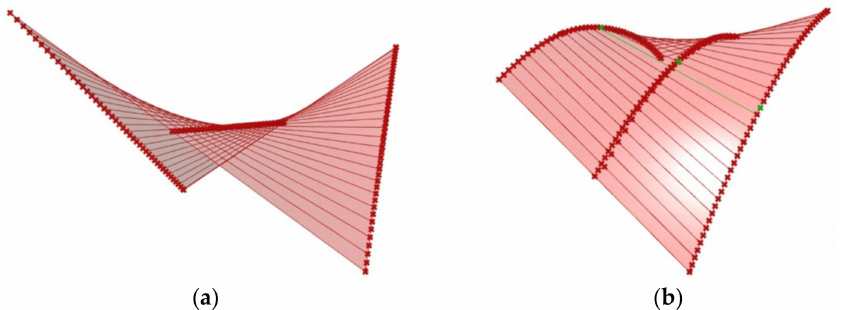
Figure 7. Smooth models of two transformed shells having straight and curvilinear lines of striction, shaped in the Rhino/Grasshopper program and defined with: ( a ) straight directrices; and ( b ) curved line of striction and